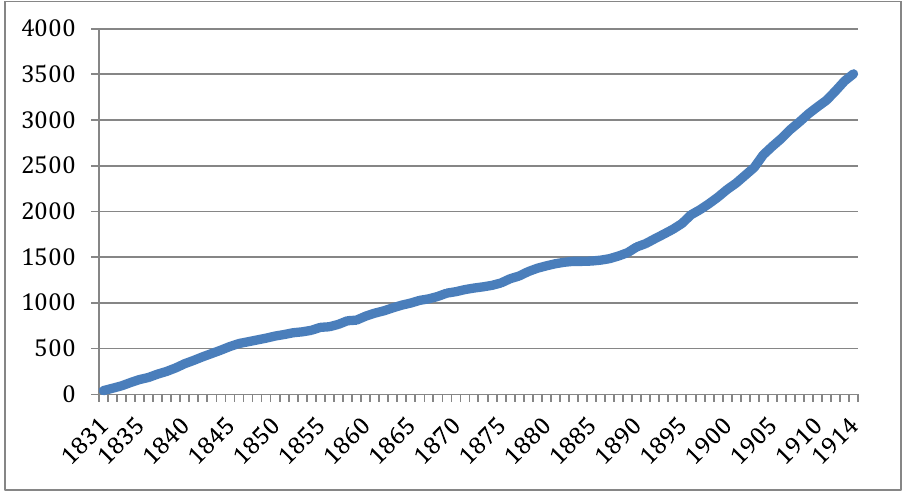
Figure 1 . Enrolled engineering students at KTH and Chalmers 1831–1914. Adapted from Ahlström